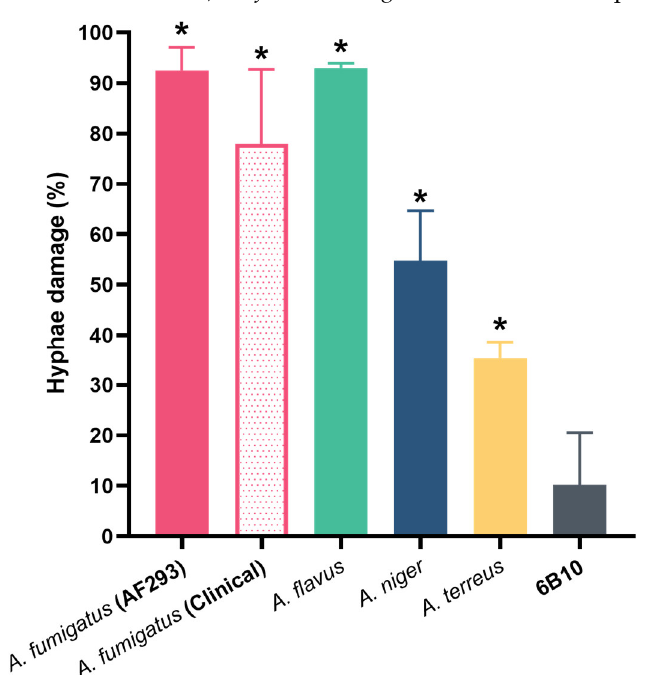
Figure 8. MAb 1D2 induced hyphae damage in various Aspergillus species. MAb 1D2 showed statistically significant effects on hyphal metabolic activity of A. fumigatus (AF 293), A. fumigatus (two clinical strains), A. flavus , A. niger and A. terreus , respectively. *: p < 0.001 versus 6B10 group.